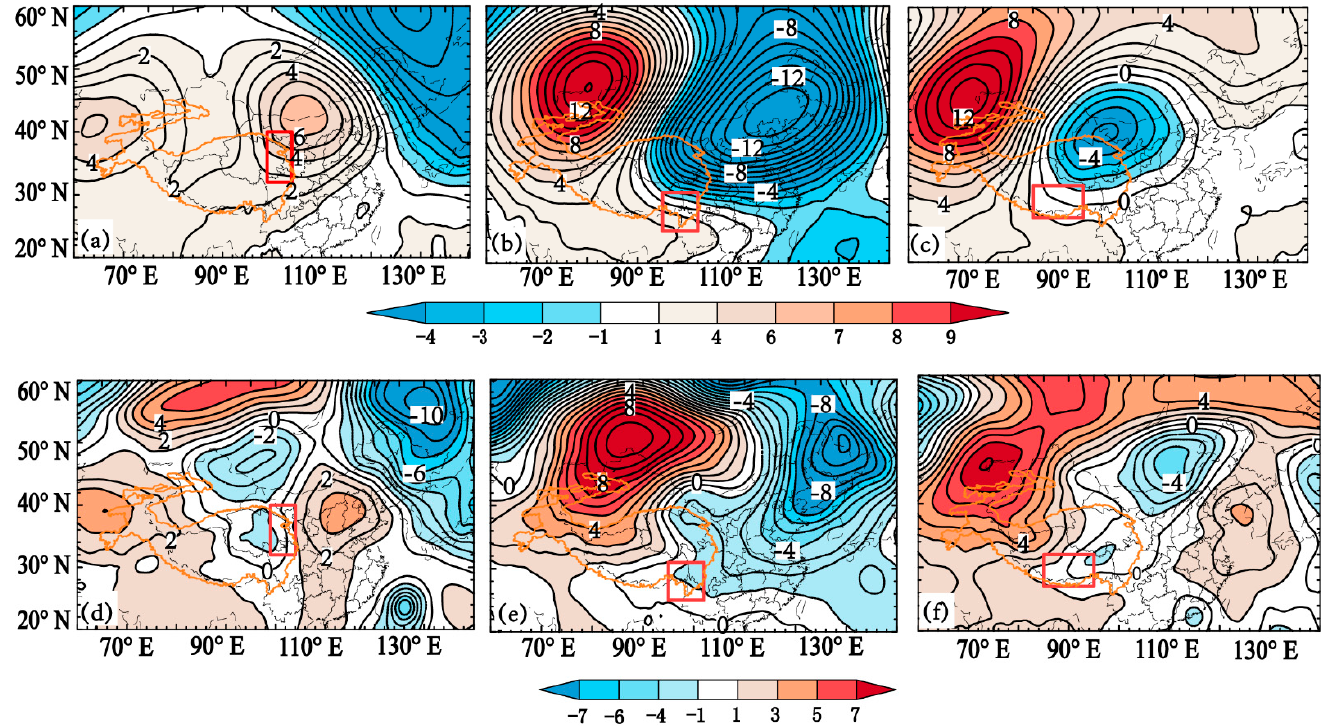
Figure 8. The composite of the height anomaly at 100 hPa for ( a ) PT-type, ( b ) PSL-type, and ( c ) PV-type precipitation events. The composite of the height anomaly at 500 hPa for ( d ) PT-type, ( e ) PSL-type, and ( f ) PV-type precipitation events. The red box represents the extreme precipitation area.